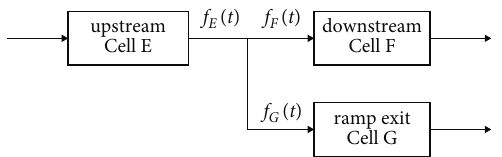
Figure 4: Schematic diagram of diverge road section of